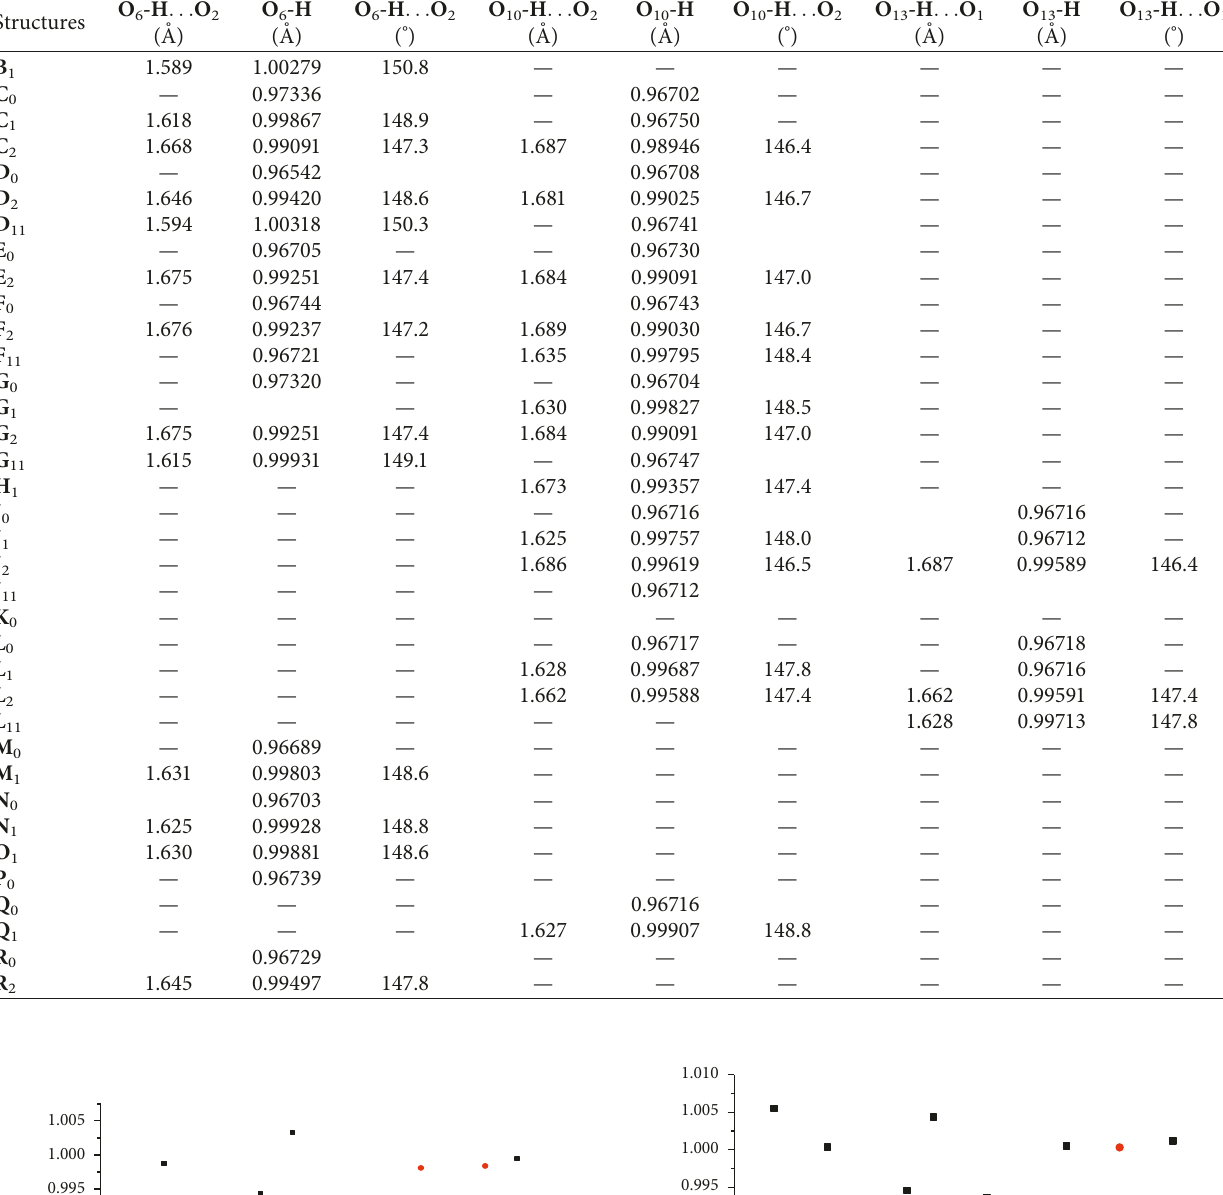
Table 1: Geometrical parameters useful to characterize hydrogen bonds (bond distances (˚A) and bond angles ( ° )) of various configurations adopted at B3LYP/6-311++G(d,p) in vacuum. Structures